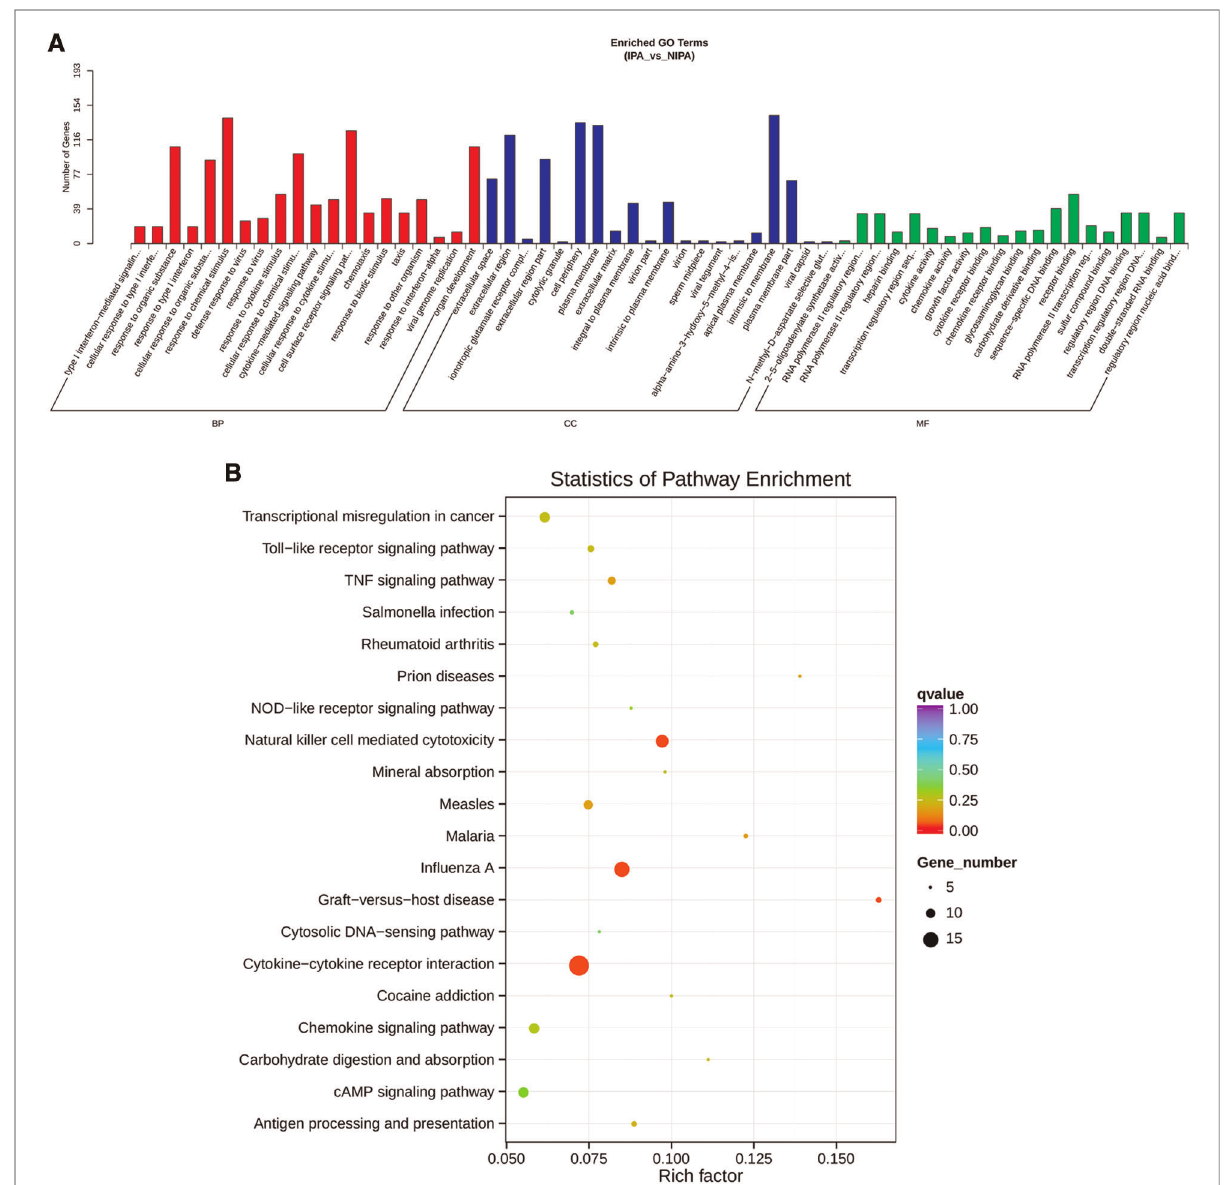
FIGURE 4 DElncRNA target gene GO and KEGG enrichment analyses. ( A ) Top 20 GO-BP, CC, and MF entries. BP, biological process; CC, cell components; MF, molecular function. ( B ) Top 20 enrichment